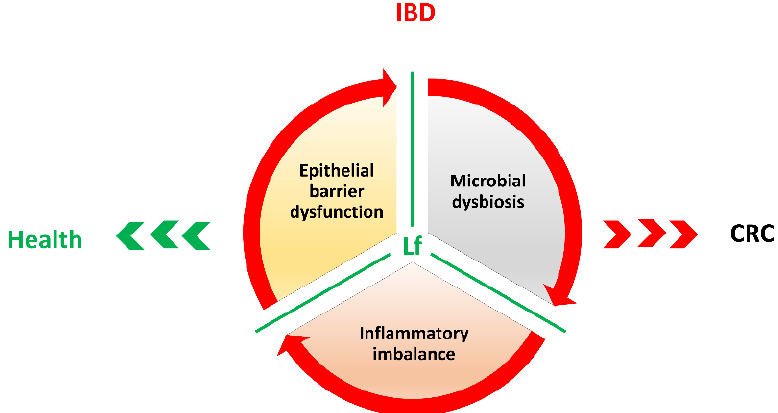
Figure 3. Summary diagram on Lf multi-targeting activities (green lines) counteracting, and potentially reverting, the unsafe vicious cycle established by microbial dysbiosis, inflammatory imbalance and intestinal barrier dysfunction in IBDs. CRC: colorectal cancer.